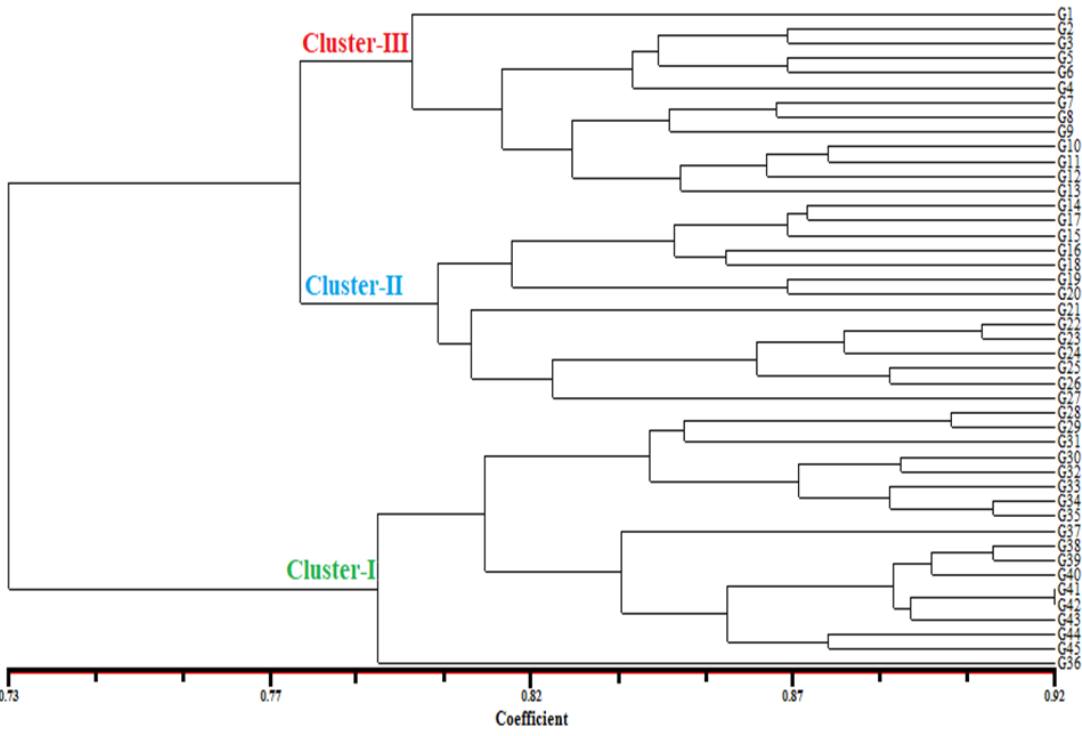
Figure 2. Dendrogram of 45-bean varieties generated with data from 26 inter primer binding site (iPBS) primers.